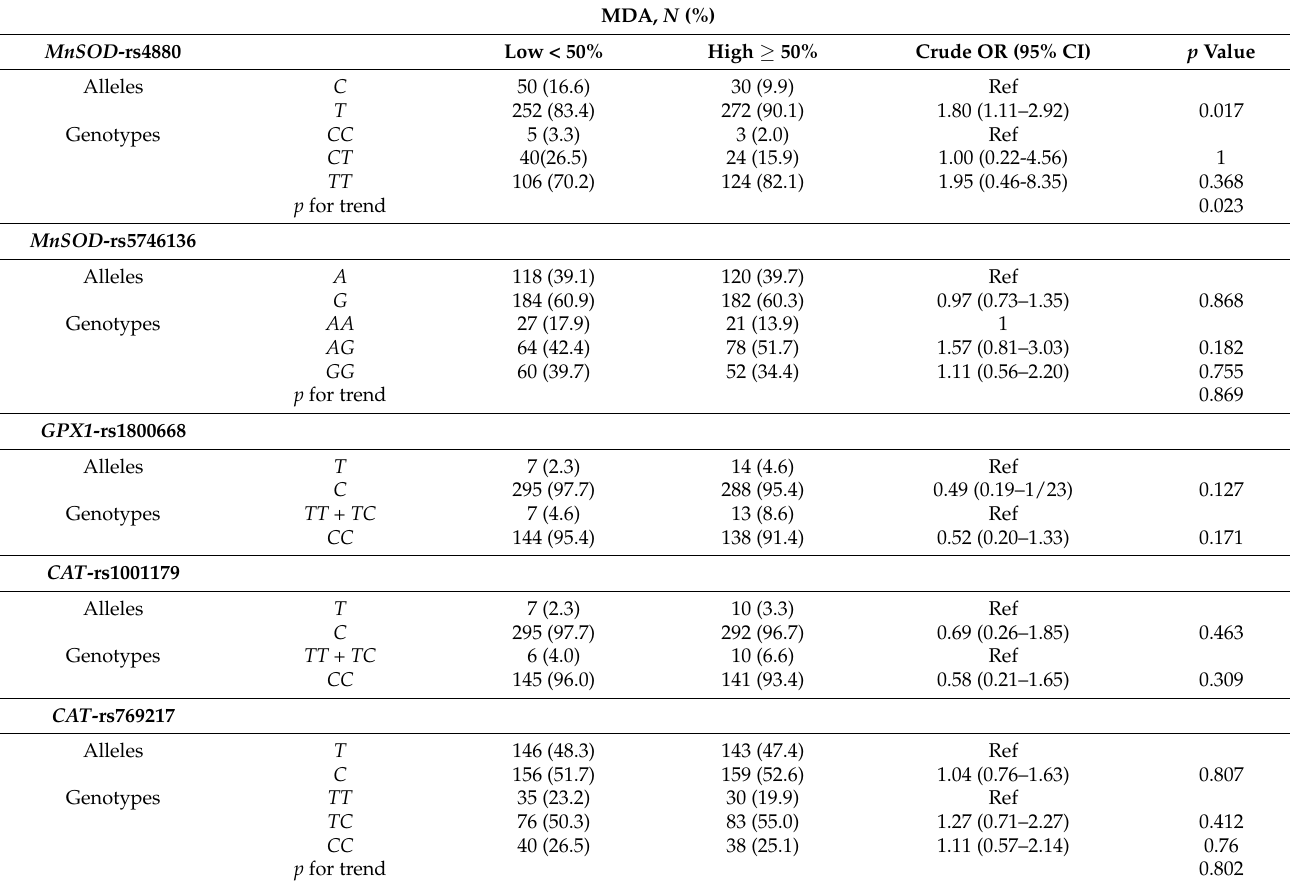
Table 3. Relationships of SNPs of antioxidant enzyme genes with a urinary biomarker of oxidative stress, MDA, in 302 calcium urolithiasis